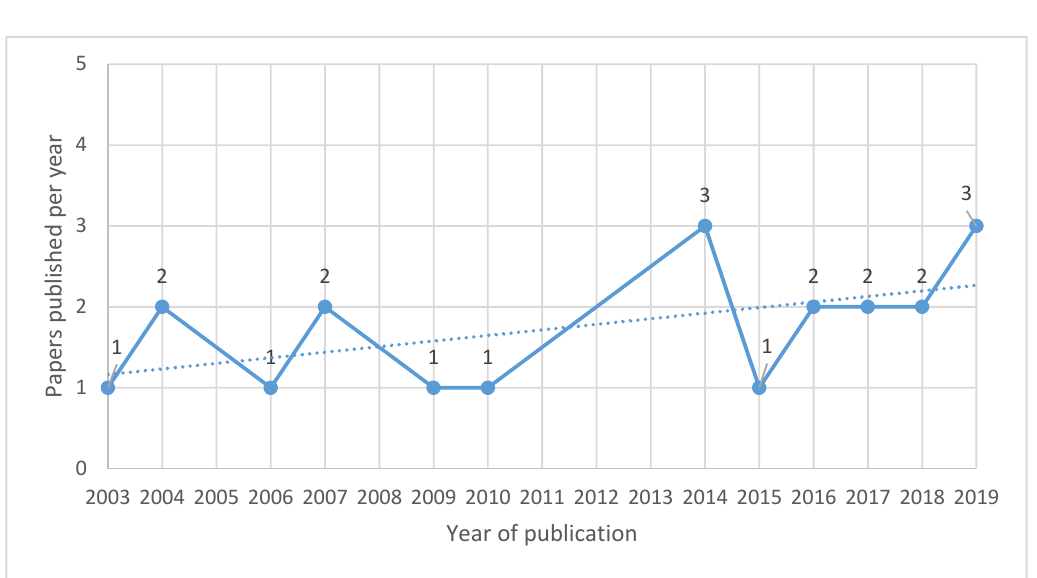
Figure 2. Number of papers published per year focused on children’s respiratory and allergic e ff ects of pesticide exposure ( n = 21).